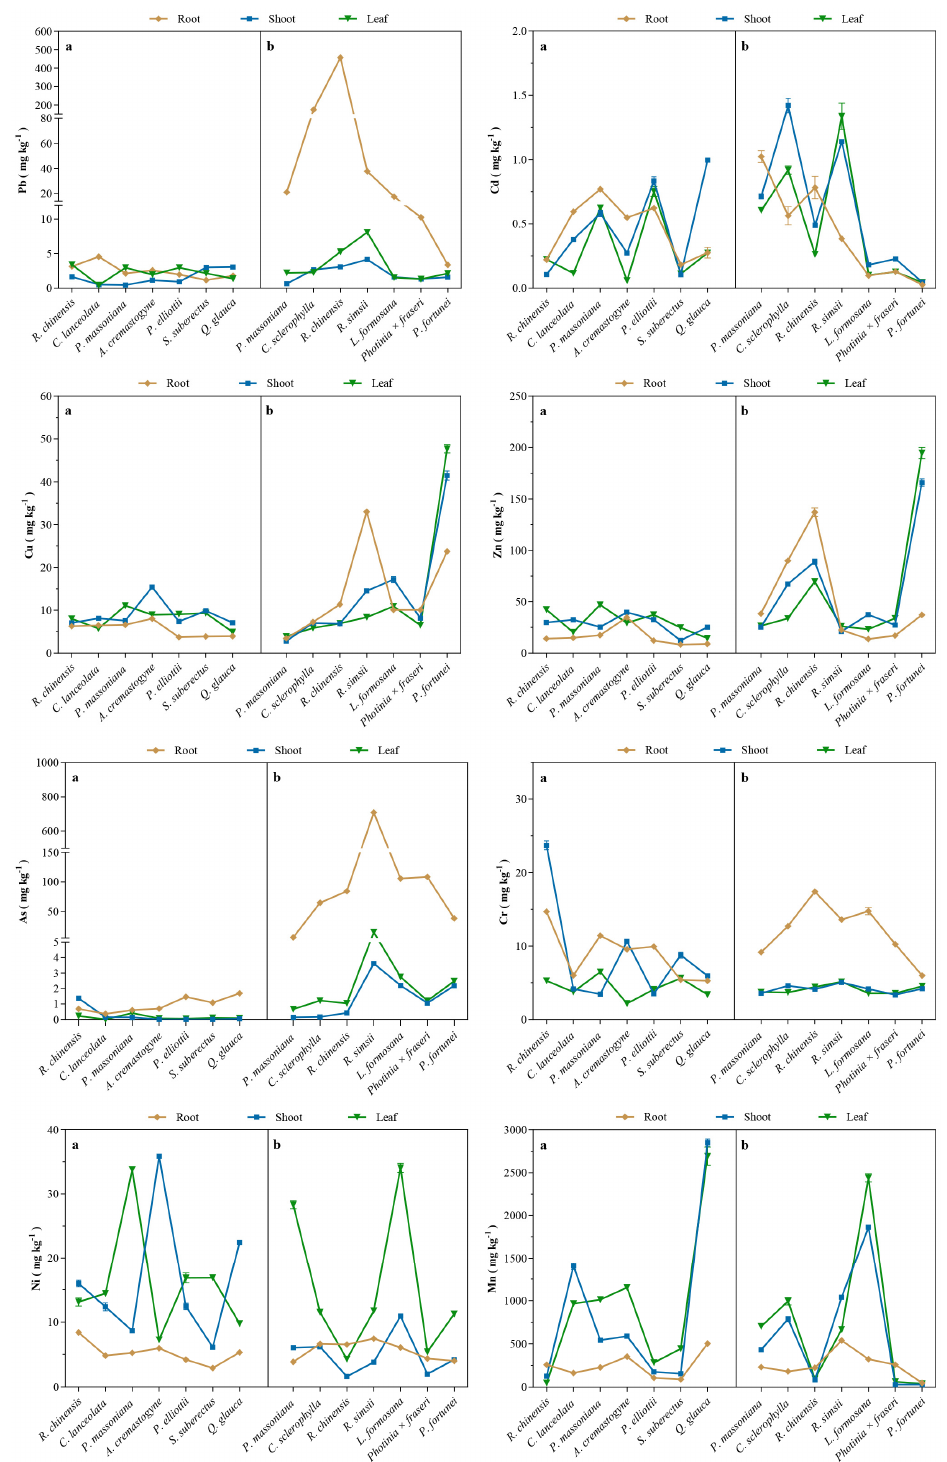
Figure 3. Heavy metals in the roots, shoots, and leaves of each woody plant in the Jiulong iron tailing area ( a ) and Yangtiangang lead − zinc tailing area ( b ).